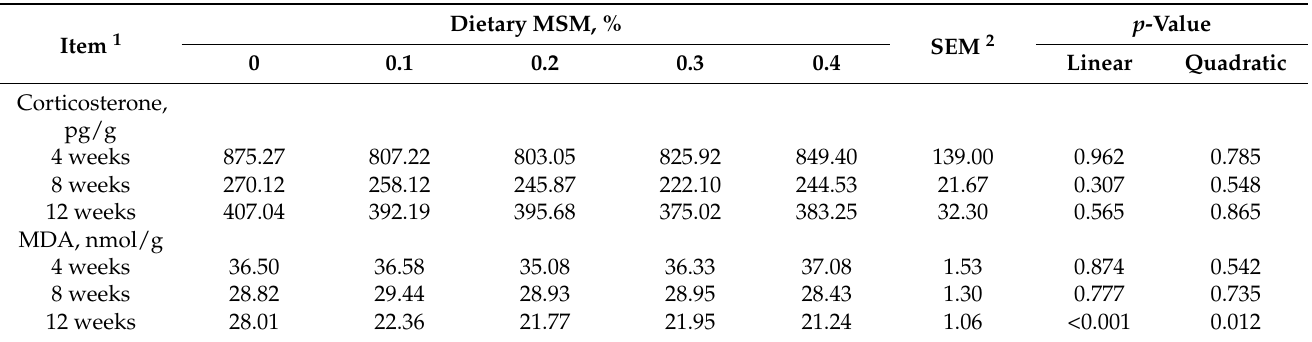
Table 4. Effects of graded levels of dietary methyl sulfonyl methane on the levels of corticosterone and malondialdehyde in the egg yolks from laying hens.